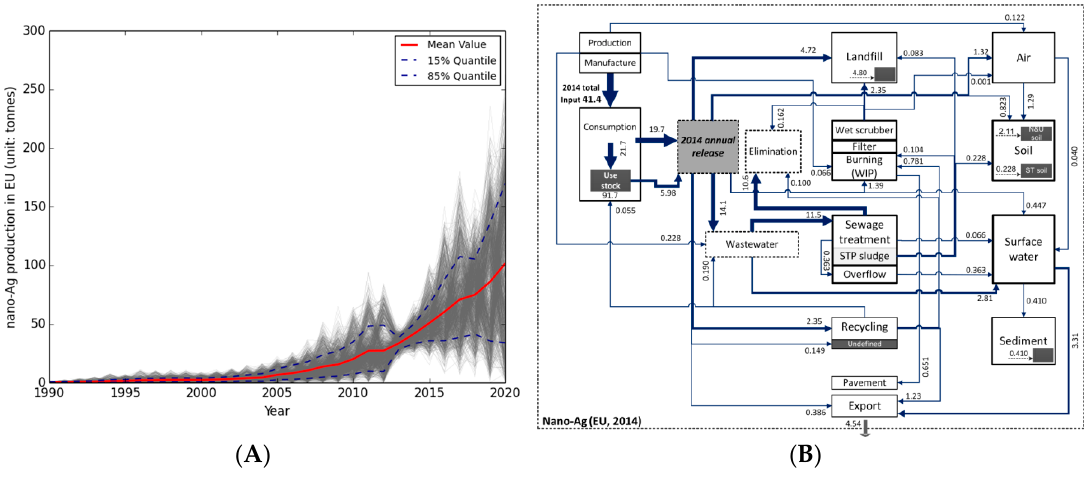
Figure 5. ( A ) and ( B ). Modelled developmental trends for nano ‐ Ag production from 1990 to 2020. The grey curve represents a random result from a probabilistic modelling. The mean values (red line) and the quantiles 0.15 (lower dashed line) and 0.85 (upper dashed line) are also shown. ( B ) Resulting dynamic modelling of mass ‐ flow for nano ‐ Ag in EU for 2014, with the arrow thickness indicating quantity of mass flow.